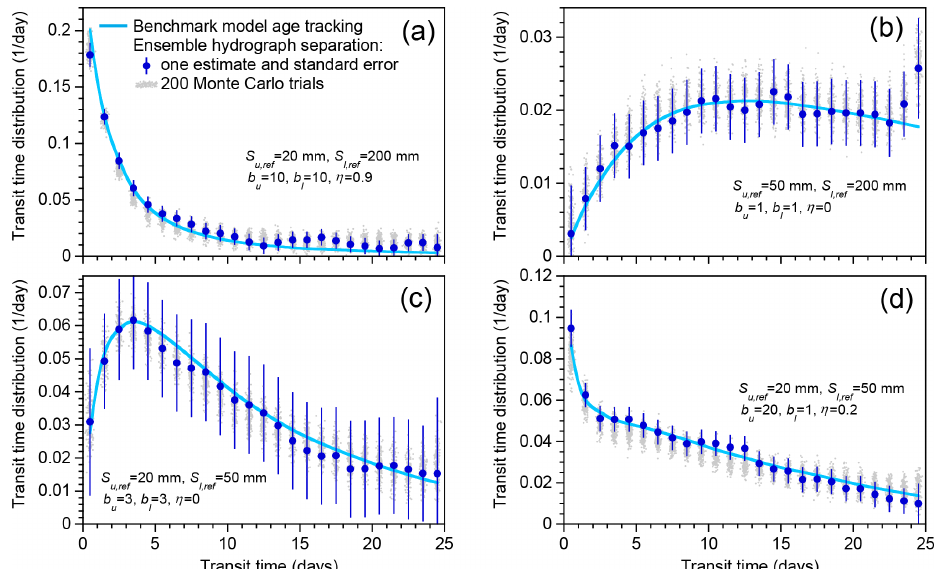
Figure 12. Transit time distributions (TTDs) of discharge estimated by ensemble hydrograph separation based on daily sampling, compared to true TTDs determined by benchmark model age tracking (light blue curves), for four model parameter sets yielding diverse patterns of transport behavior. Dark blue symbols show transit time distributions estimated from one time series. Data clouds show ensemble hydrograph separation results (slightly jittered on the horizontal axis) from 200 different realizations of random precipitation tracer values, random missing data, and random measurement errors. Vertical axis scales differ greatly. Ensemble hydrograph separation correctly reveals the shapes of the TTDs and also quantifies their values at most lags. However, panels (b) and (c) show that standard errors are overestimated for TTDs that result in strong serial correlation in the modeled time series (see